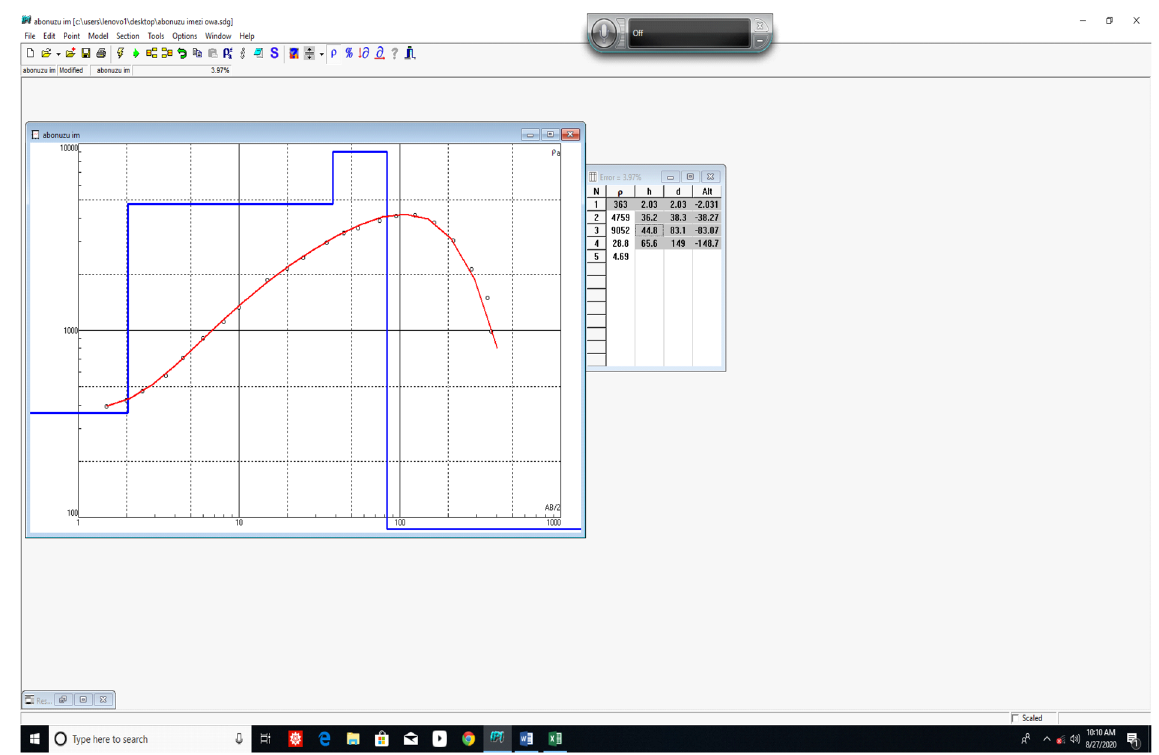
Fig. 4 AKQ-type curve for VES (2, 3 and